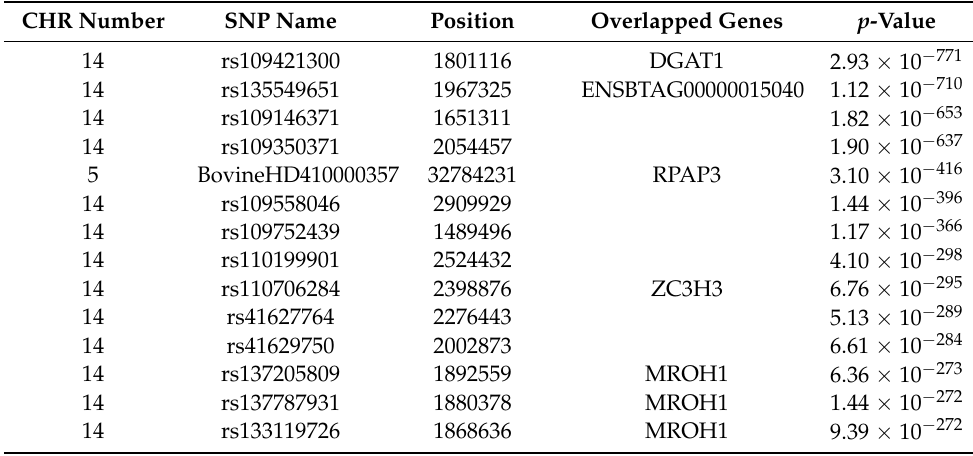
Table 2. The detailed information of top 50 detected SNPs via meta-analysis in milk